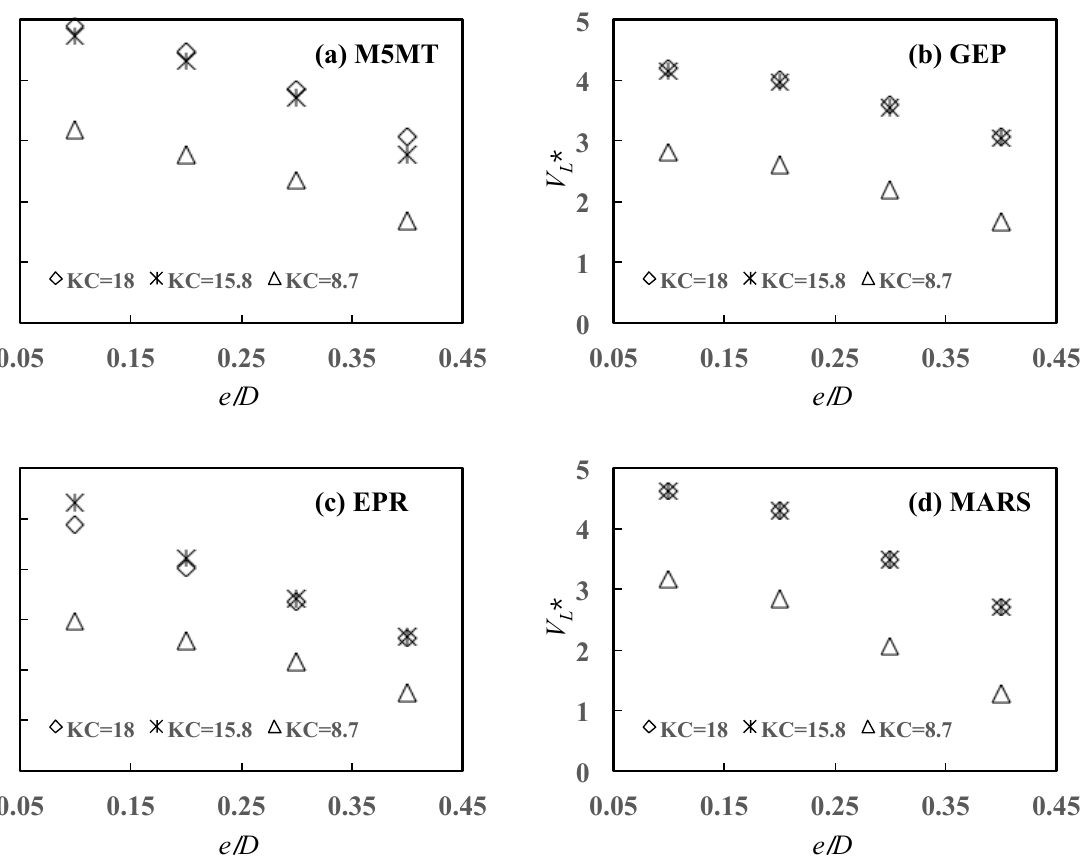
Figure 11. Variations of 𝑉 𝐿 ∗ against 𝑒 𝐷⁄ at KC from 8.7 to 18.0 and α = 0° for: ( a ) M5MT, ( b ) GEP, ( c ) EPR, and ( d ) MARS.